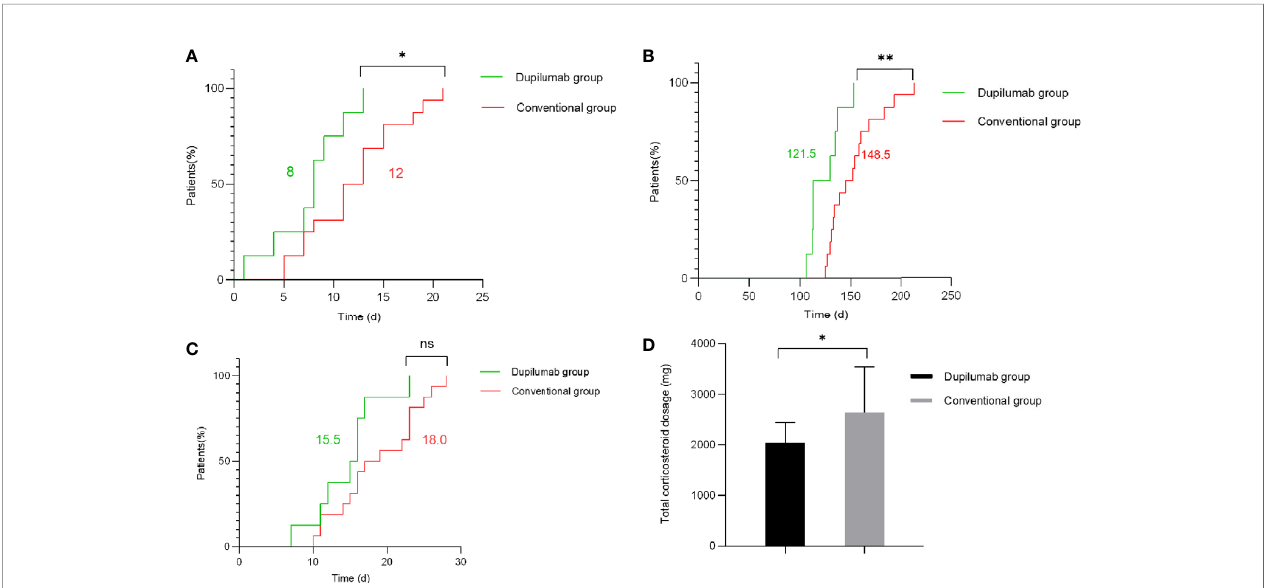
FIGURE 2 | Primary outcomes in the dupilumab group compared with the conventional group. (A) Time to stop new blister formation ( p = 0.028 by Kaplan-Meier analysis). (B) Time to reduce the systemic glucocorticoids to minimal dose (methylprednisolone 0.08 mg/kg/day) ( p = 0.0053 by Kaplan-Meier analysis). (C) Hospitalization duration ( p > 0.05 by Kaplan-Meier analysis). The numbers in green and red represent the median number of days for the dupilumab group and conventional group, respectively. (D) The total amount of methylprednisolone administered to patients in the dupilumab group and conventional group (at the time of reaching the minimal dose) ( p = 0.036 by Mann-Whitney U test) (* p < 0.05; ** p < 0.01; ns, not signi fi